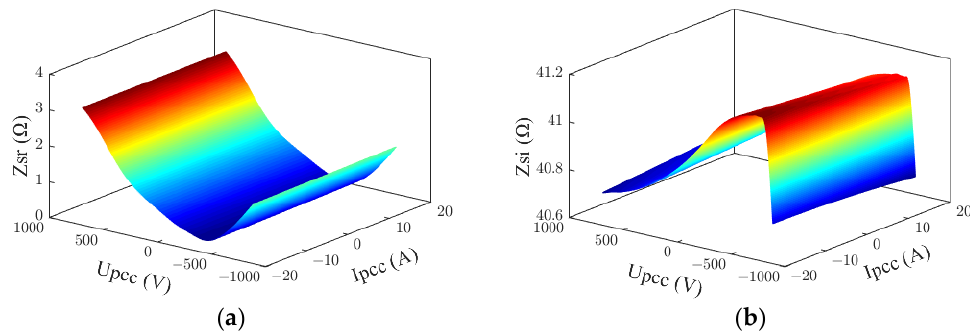
Figure 21. Results of method 1 in 7th harmonic. ( a ) Real part; ( b ) Imaginary part. Table 8. Evaluation indexes of method 1 in 7th harmonic.